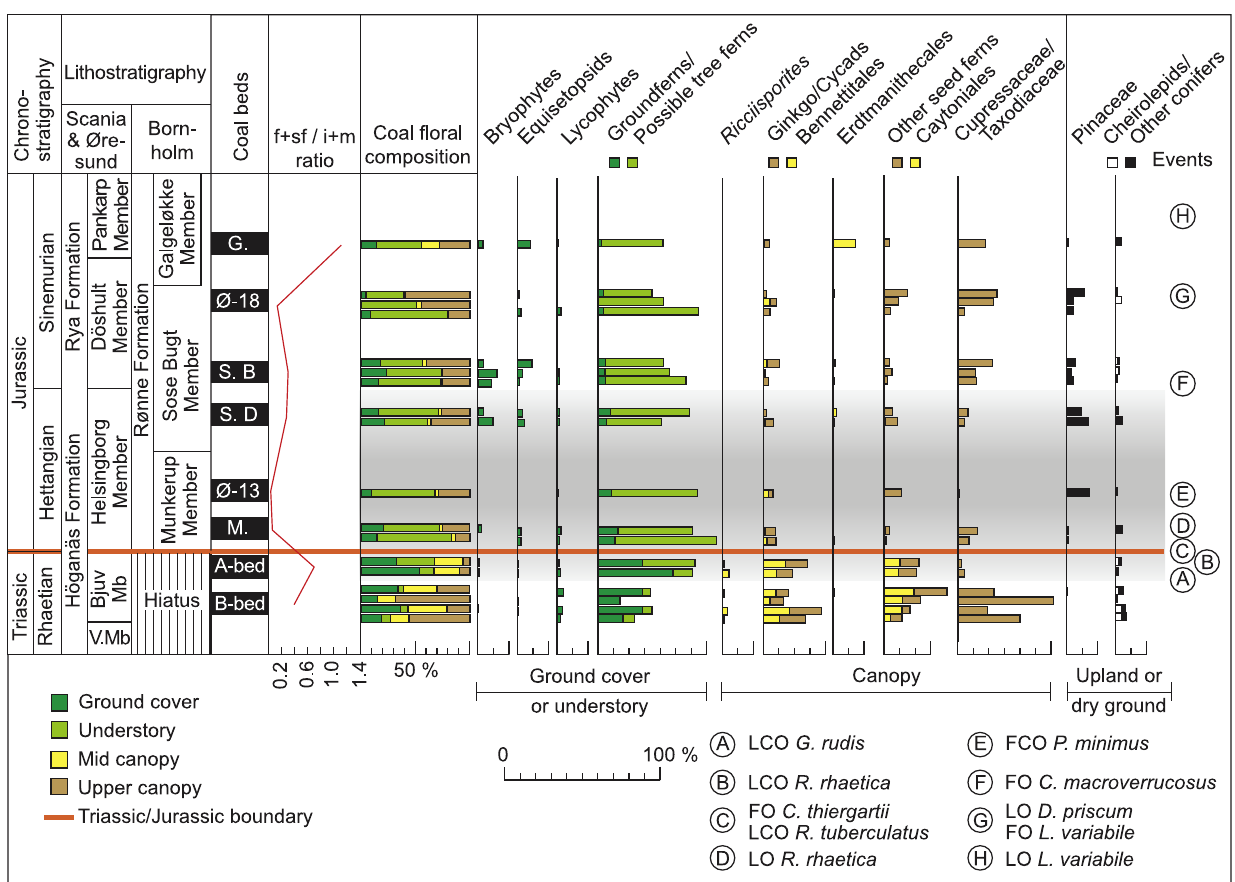
Figure 3. Mire floral composition from coal/coaly beds across the T–J boundary based on spores and pollen. Chrono- and lithostratigraphy is based on [2] and [5]. V.Mb = Valla˚kra Member. The stratigraphic positions of the coal/coal beds are based on previous studies [2,33–35] and on the palynological data in this paper. The detailed f + sf/i + m ratio (red curve) demonstrates a dominance of detrital inertinite in the Hettangian coal/coaly beds. The coal floral composition is calculated from spore/pollen abundances of probable mire taxa only, while the total abundances of the various plant groups are based on all spores and pollen, including those regarded to have been produced by upland or dry ground plants. The Ginkgos/Cycads/Bennetittales category probably also includes pollen produced by peltasperms (seed ferns). A to E represent palynostratigraphic events, both marine and terrestrial, where FO = First occurrence, FCO = First common occurrence, LO = Last occurrence, and LCO = Last common occurrence. A: LCO of Granuloperculatipollis rudis , B: LCOs of Rhaetogonyaulax rhaetica and Ricciisporites tuberculatus , C: FO of Cerebropollenites thiergartii , the accessory marker for the T–J boundary, D: LO R. rhaetica , E: FCO of Pinuspollenites minimus , F: FO of Cerebropollenites macroverrucosus , G: LO of Dapcodinium priscum and FO of Liasidium variabile , and H: LO of Liasidium variabile . Thick red line marks the T–J boundary.